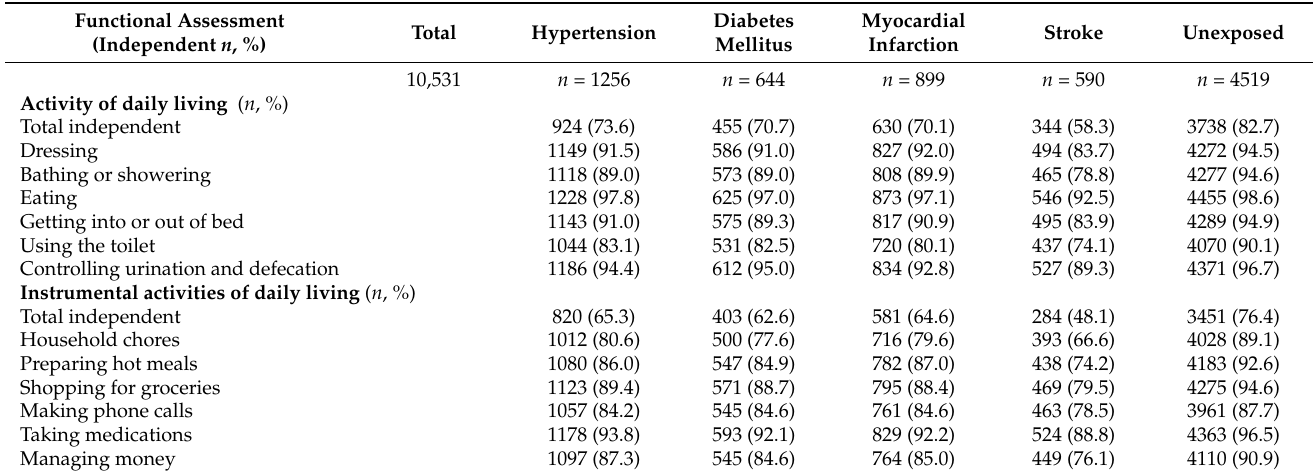
Table 3. Functional ability in the presence of vascular disease.